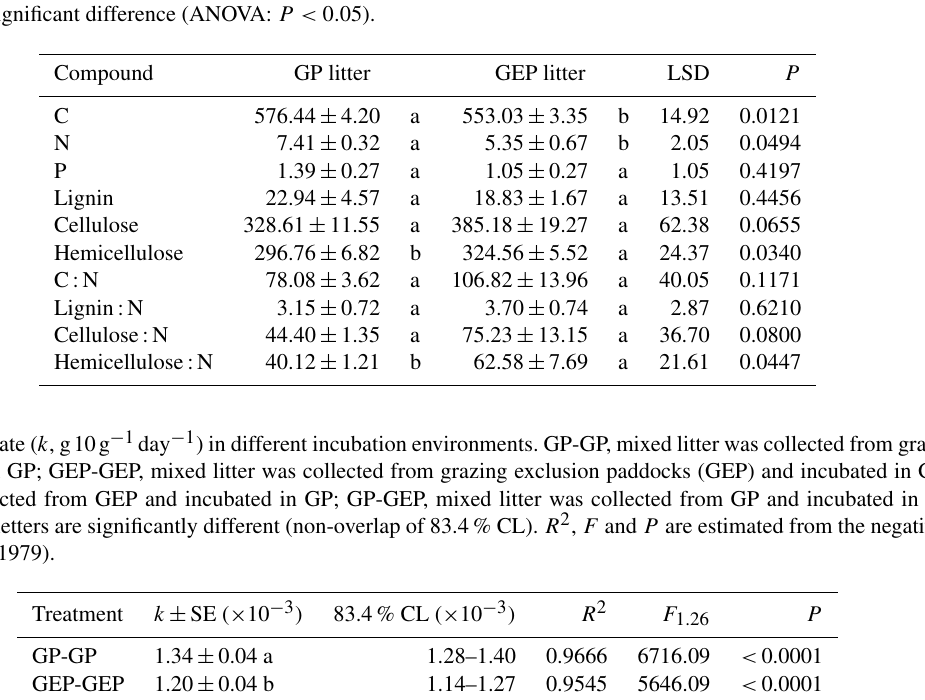
Table 1. Initial chemical characteristics (mean ± SE) of litter collected from grazing paddocks (GP litter) and grazing exclusion paddocks (GEP litter). Unit of chemical characteristics is milligrams per gram of litter for C, N, P, lignin, cellulose and hemicellulose. Different letters in each row indicate significant difference (ANOVA: P < 0 . 05).